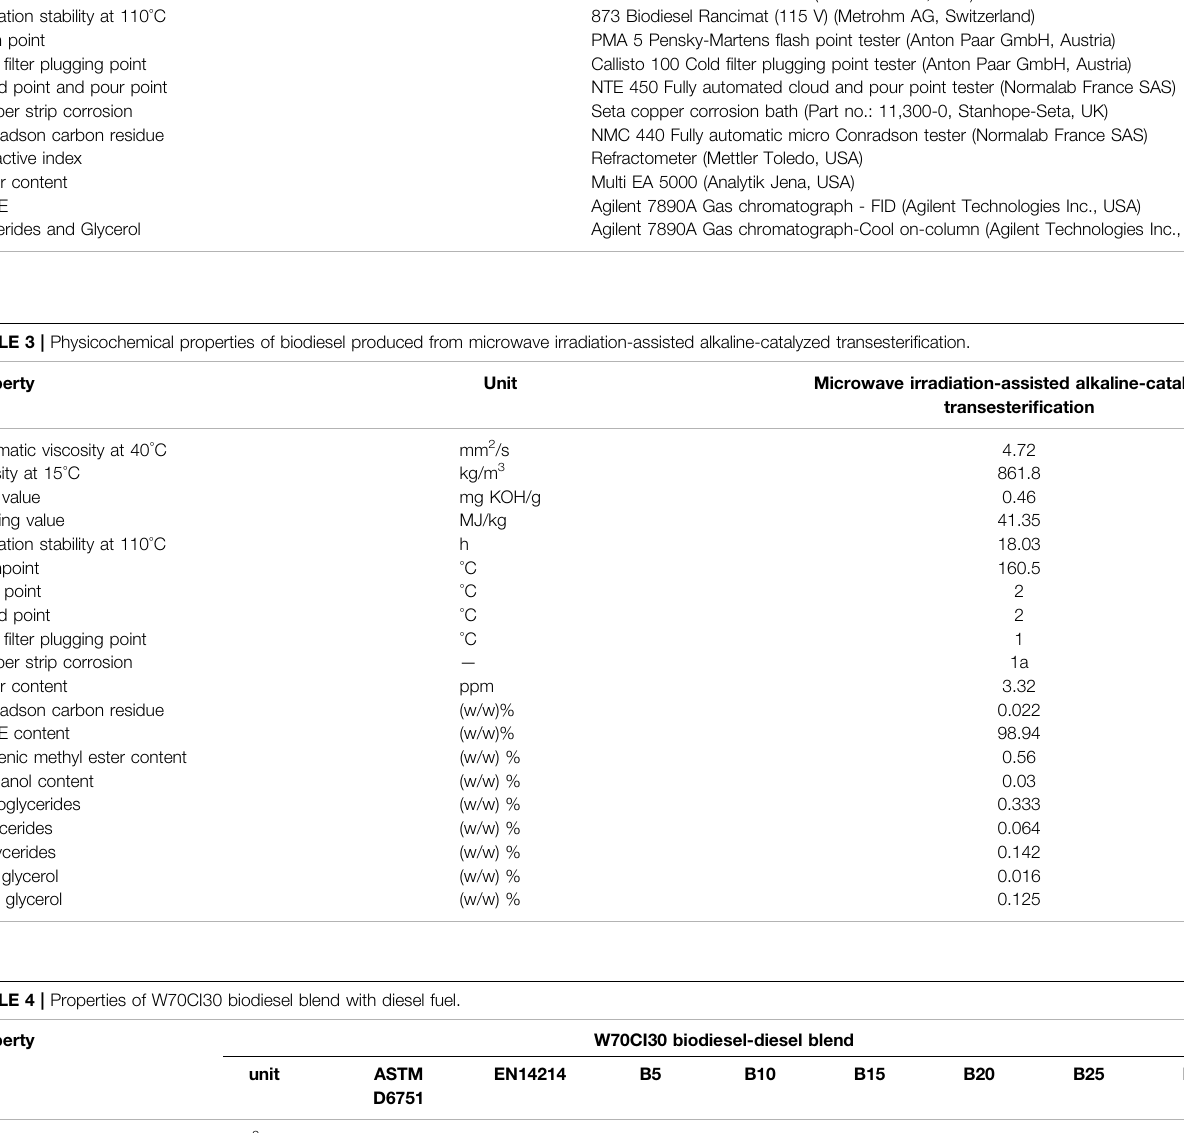
Kinematic viscosity at 40 °